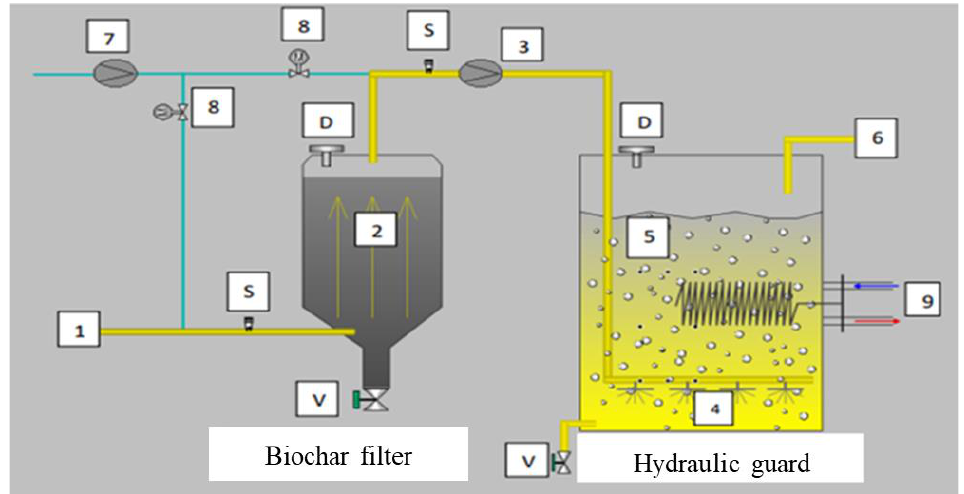
Figure 2. Overall drawing of the anaerobic digestion biogas desulfurization system by biochar filter and liquid margin suspension culture reactor: 1: raw biogas inlet; 2: biochar filter; 3: biogas injection system under pressure; 4: pressurized biogas diffusers; 5: Hydraulic guard; 6: cleaned biogas outlet to use; 7: oxygen injection system; 8: oxygen control valves in the biogas; 9: heat exchanger; S: oxygen control probes; D: nutrient injection point (margin or others; V: Purge or drain valve.).